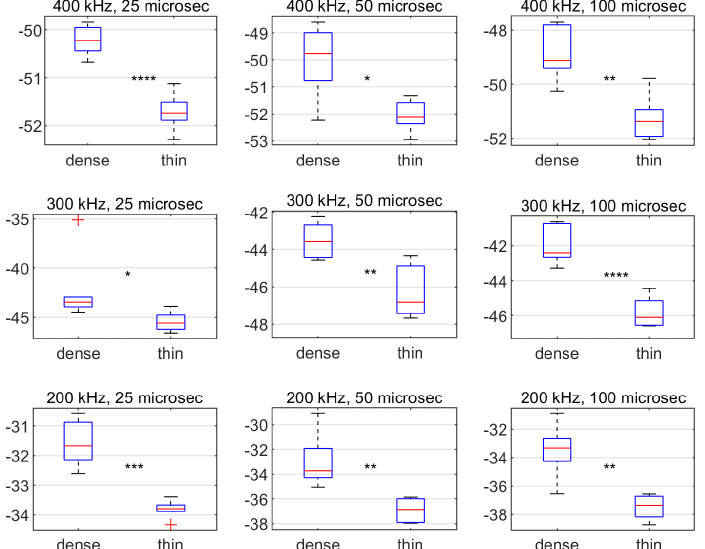
Figure 13. Average of the filtered backscatter level recorded within the target volume, displayed as box plots for each patch setup and each combination of sonar settings: ( top left ) 400 kHz and 25 μs pulse, ( top ) 400 kHz and 50 μs pulse , ( top right ) 400 kHz and 100 μs pulse, ( left ) 300 kHz and 25 μs pulse, ( middle ) 300 kHz and 50 μs pulse, ( right ) 300 kHz and 100 μs pulse, ( bottom left ) 200 kHz and 25 μs pulse, ( bottom ) 200 kHz and 50 μs pulse, ( bottom right ) 200 kHz and 100 μs pulse . On each plot, the red line represents the median value, the box represents the quartile estimates, and the error bars show the full data range (minimum and maximum). The symbol in the centre of each panel represents the result of a Welch's unequal variances t -test of the hypothesis of equal mean between each patch setup (* p < 0.05, ** p < 0.01, *** p < 0.001, **** p < 0.0001).